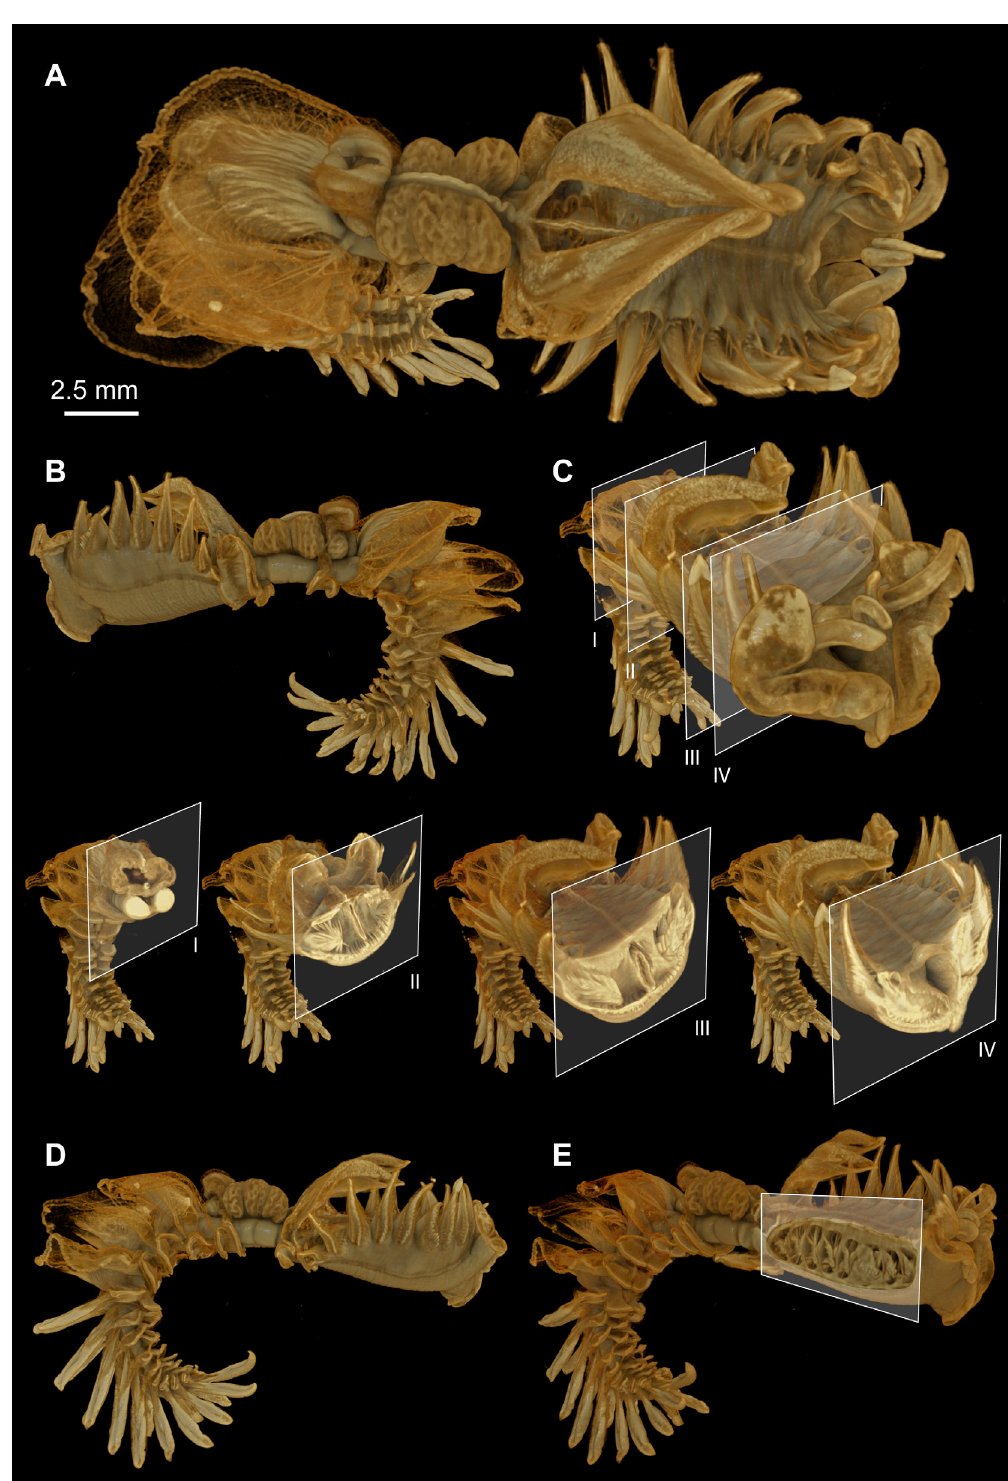
Fig. 4. Chaetopterus dewysee sp. nov. micro-CT surface renderings of the cybertype (SIO-BIC A12034). A . Dorsal view of the whole specimen. B . Lateral view of the whole specimen. C . Frontal view with virtual dissection planes (I–III) showing cross-sections along the body. D–E . Lateral view with a virtual dissection window showing the parapodial musculature of region A. Direct link to cybertype: